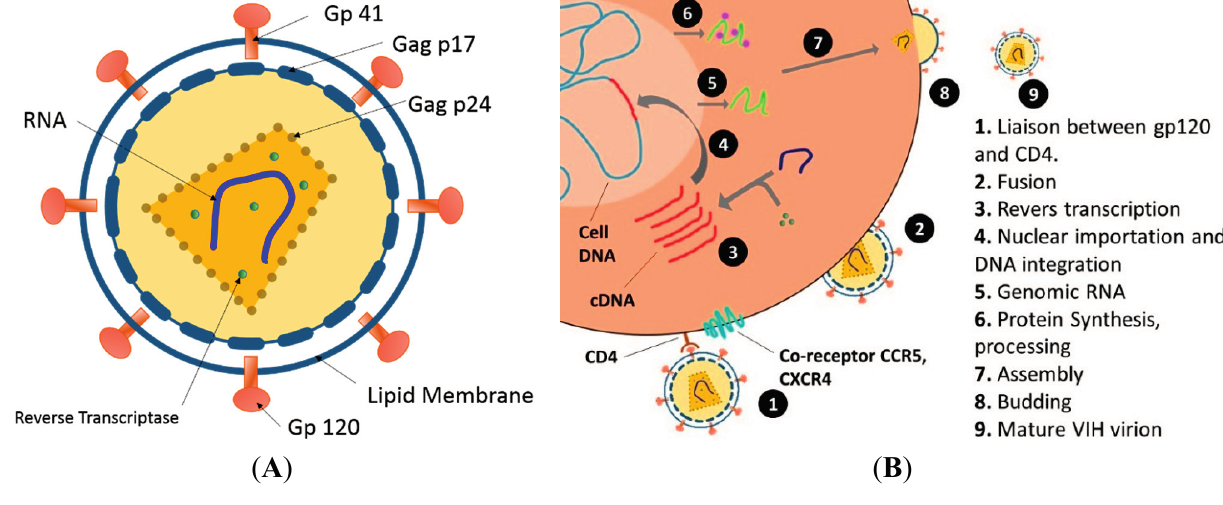
Figure 3. ( A ) Structure of HIV; ( B ) HIV replication cycle